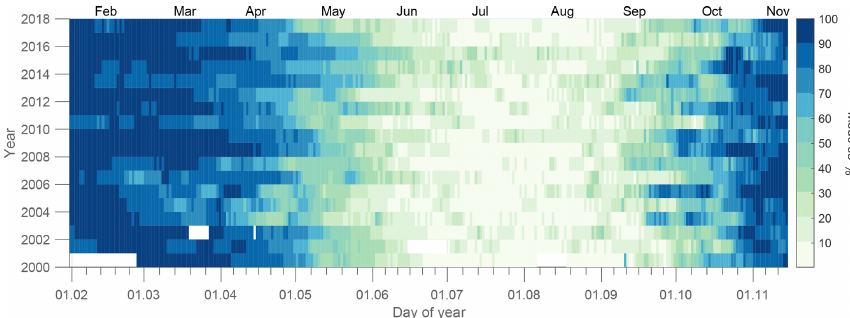
Figure 9. Snow cover duration (SCD) in Iceland from 1 March 2000 to 31 December 2017; 100% indicates full snow cover, while 0% represents a snow-free area. Glaciers and water bodies are not included.